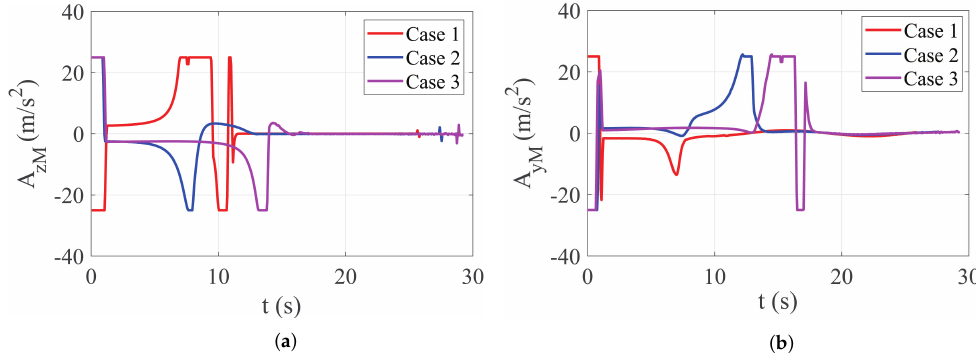
Figure 11. Variations of acceleration commands against variable maneuvering targets: ( a ) acceleration commands in pitch plane; ( b ) acceleration commands in yaw plane.